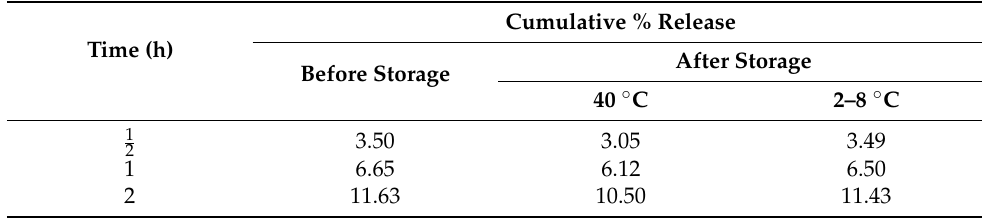
Table 8. Comparative in vitro diffusion profiles of Timolol maleate nanoemulsion in situ gel before and after storage at 3